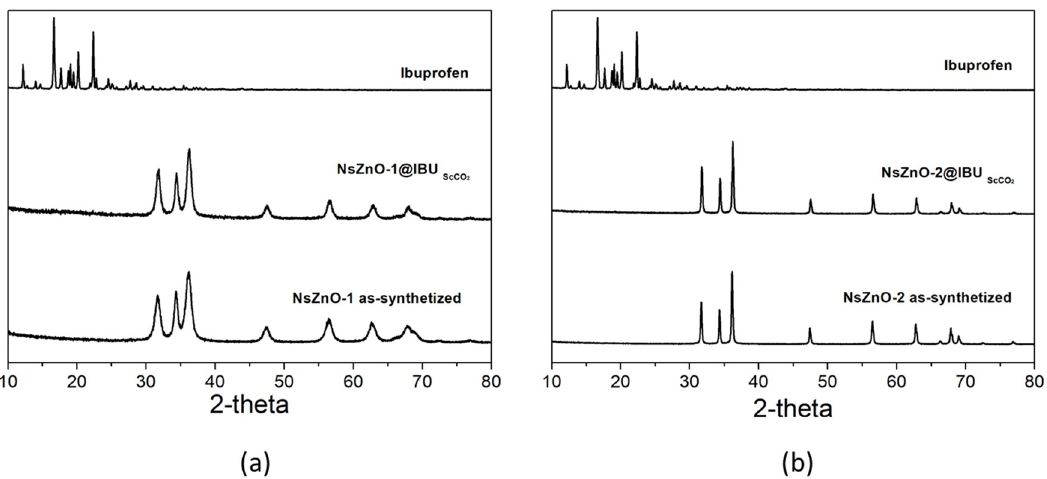
Figure 5. ( a ) XRD patterns of NsZnO-1, IBU@NsZnO-1, and pure crystalline IBU. ( b ) XRD patterns of NsZnO-2, IBU@NsZnO-2, and pure crystalline IBU.